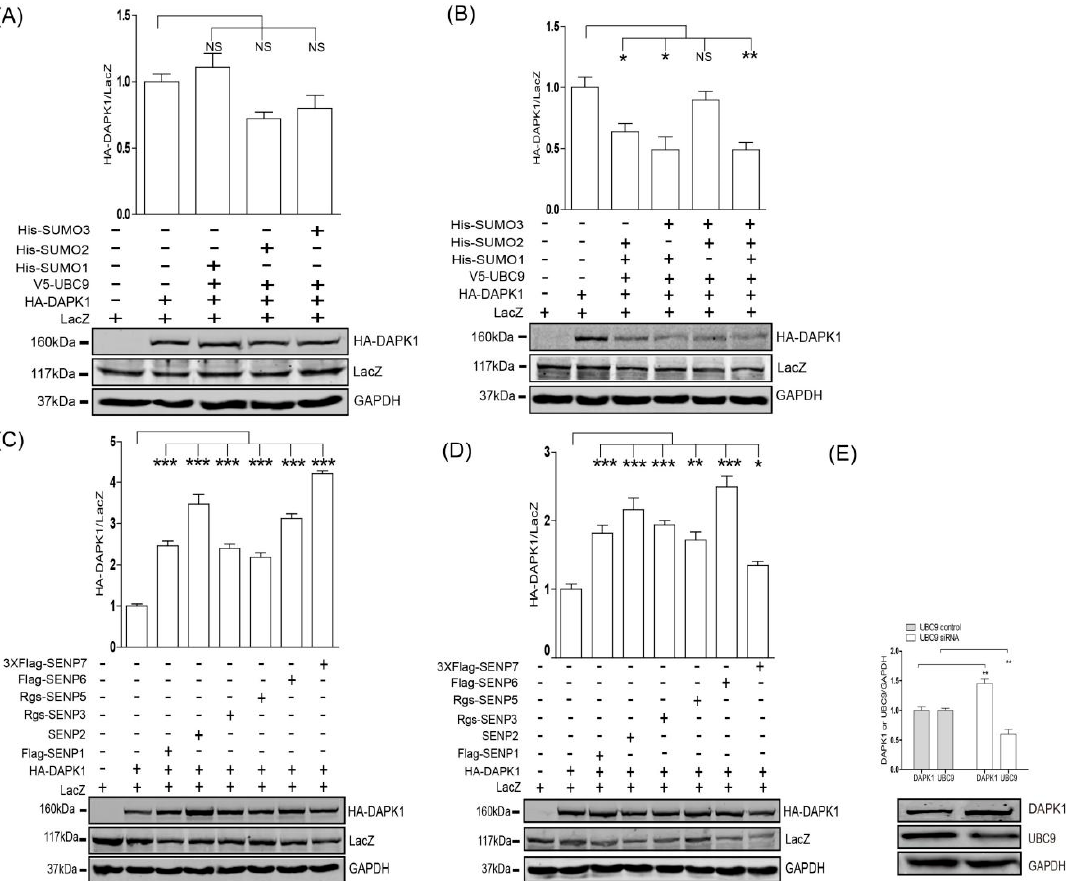
Figure 2. The SUMO pathway regulated the protein levels of DAPK1. HEK293T were transfected with ( A ) HA-DAPK1, LacZ, V5-UBC9, His-SUMO-1, His-SUMO-2 or His-SUMO-3, or ( B ) HA-DAPK1, LacZ, V5-UBC9, His-SUMO-1, His-SUMO-2 or His-SUMO-3, or ( C ) HA-DAPK1, LacZ and six di ff erent SENPs, or ( E ) control and UBC9 siRNA as indicated. HCT116 were transfected with ( D ) HA-DAPK1, LacZ and six di ff erent SENPs as indicated. Cell lysates were extracted 48 h post-transfection and immunoblotted with respective antibodies. The intensity of the bands was quantified using LICOR Odyssey software and represented by bar graphs. The experiments were repeated three times (n = 3) and representative images are presented. The representative western blot images are from di ff erent gels and each lane was loaded with the same amount of proteins. Data of triplicate assays are presented as mean ± S.D. * p < 0.05; ** p < 0.01; *** p < 0.001; NS, no significance. “ + ” indicated that the plasmid was transfected, “ − ” indicated that the plasmid was not